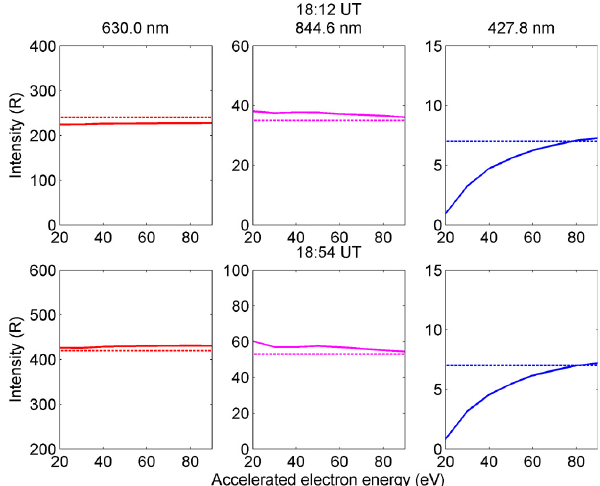
Fig. 7. The emission intensity dependence on energy of the accel- erated electrons. The top row corresponds to the heating pulse at 18:12UT. The bottom row corresponds to 18:54UT. The solid lines show the calculated emission intensities. The dashed lines indicate the values of the emission intensities observed in the experiment. ≡ I exp I mod 6300 6300